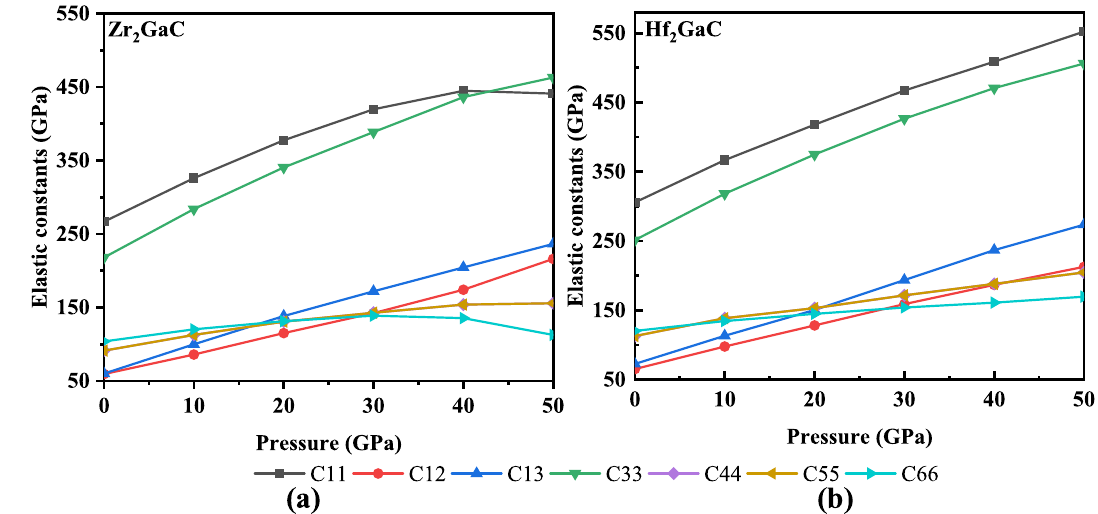
Figure 9. Elastic constants for M 2 GaC MAX phase (M = Zr, Hf) in function of pressure.